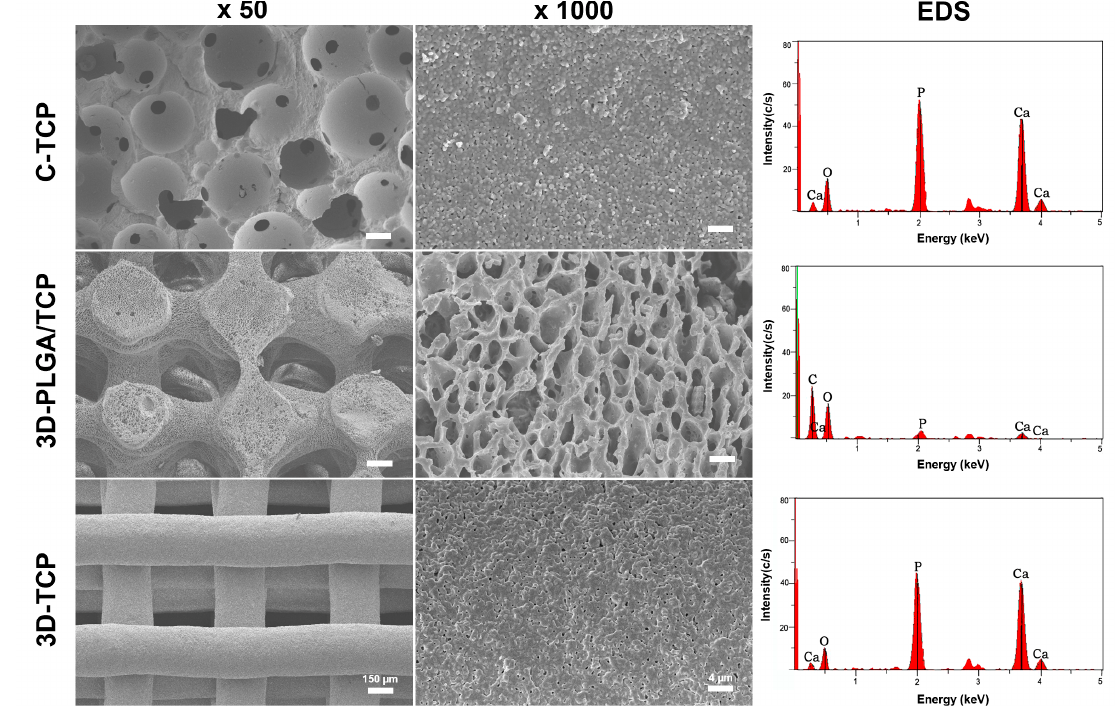
Figure 2. Characterizations of C-TCP, 3D-PLGA / TCP, and 3D-TCP sca ff olds. SEM images showed the 3D interconnected structure and sca ff old surface, and EDS-based assessments indicated the presence of β -TCP in these three sca ff